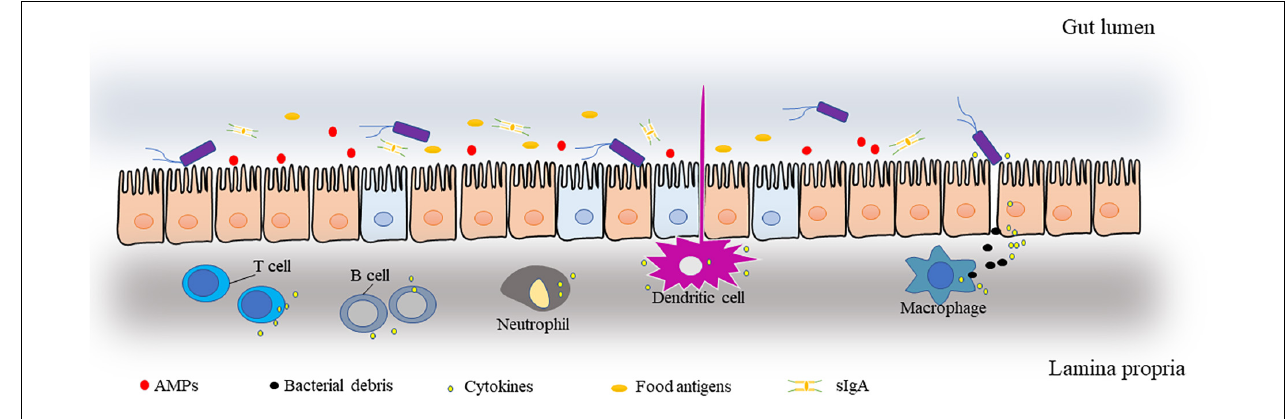
FIGURE 1 | Schematic representation of the main components of the intestinal barrier.